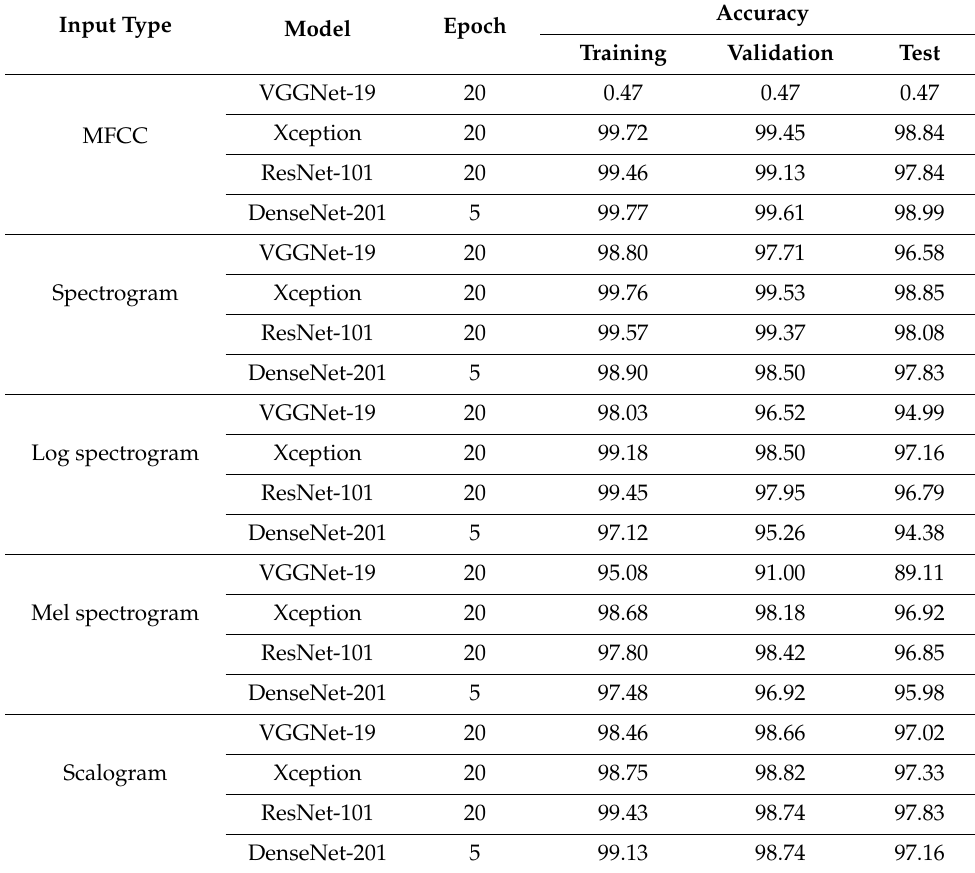
Table 3. Accuracies achieved by various models based on the CNN using di ff erent time-frequency representations on